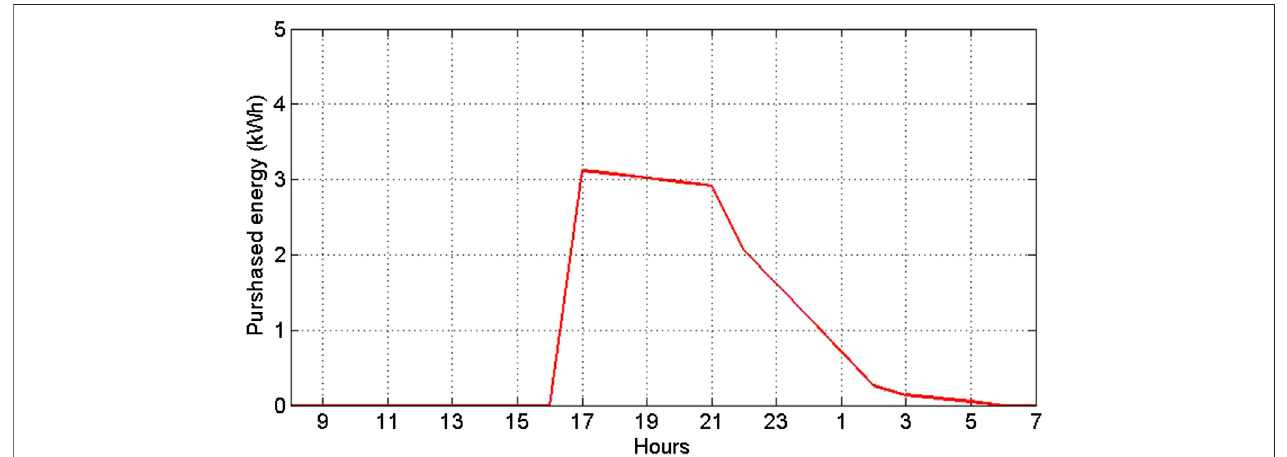
FIGURE 10 | Purchased energy from the main grid.